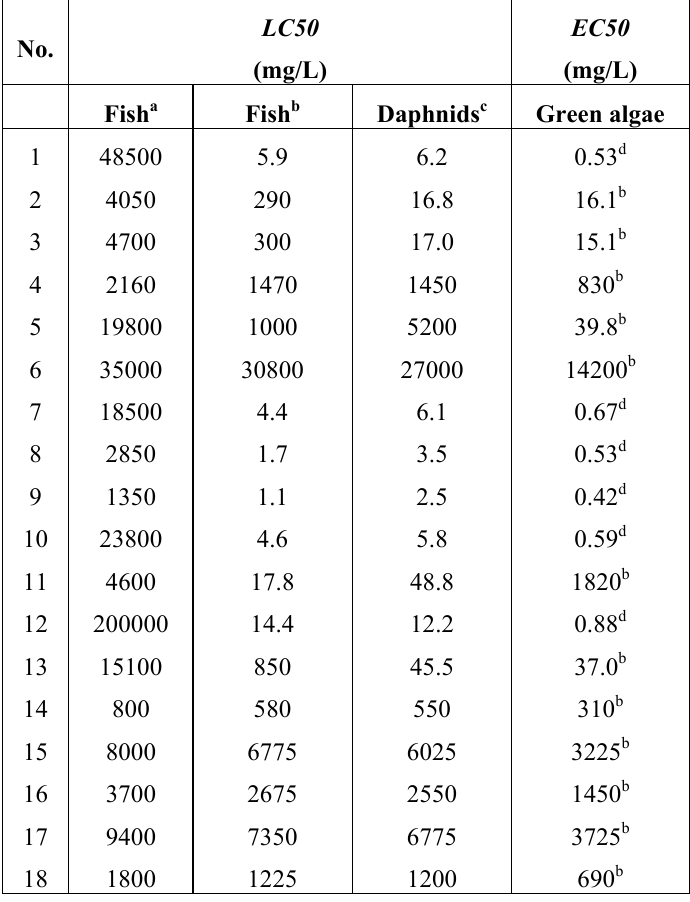
Table 3 . ECOSAR derived baseline and acute toxicity of the investigated compounds (values above 100 are rounded)